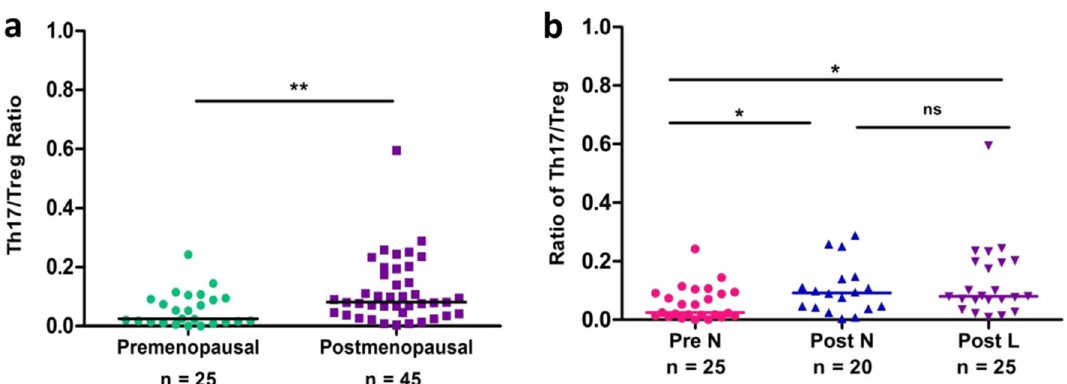
Figure 3. Ratio of circulating Th17/Treg cells in premenopausal women (n = 25) and postmenopausal women (n = 45) ( a ) and in 3 cohorts ( b ): Pre-N (n = 25), Post-N (n = 20) and Post-L (n = 25). Th17 cells were identified as CD3 + CD8 − 1L-17 + and Treg as CD4 + CD25 hi CD127 low/− . Statistical significance was estimated by Mann–Whitney U test for pairwise comparison and Kruskal–Wallis ANOVA with Dunn’s post-hoc analysis for multiple groups. The level of significance was considered only when p values were <